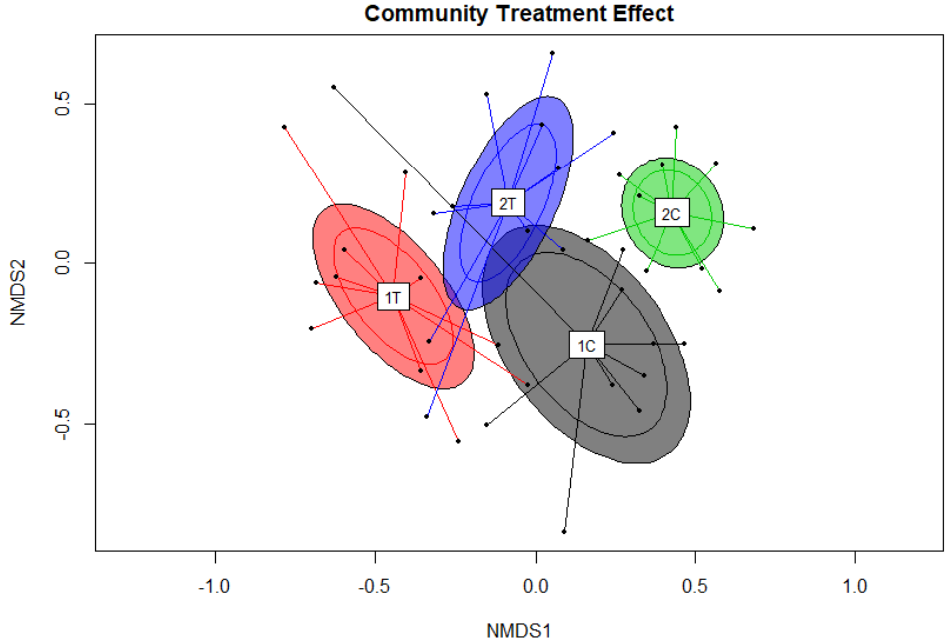
Figure 3. Ordination plot showing significant invertebrate community differences between Site 1, control and treatment plots (1C and 1T respectively) and Site 2 control and treatment plots (2C and 2T respectively) ( p < 0.001, R 2 = 0.5021, stress 0.21). Individual samples are denoted by black dots, which are connected to their respective centroid. Lower and upper 95% confidence intervals (shaded area) for each centroid are also shown.